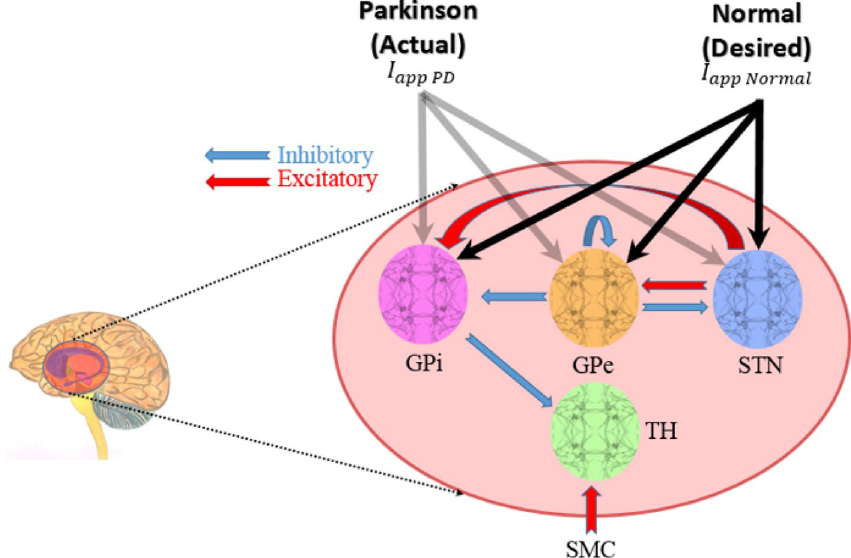
Figure 1. The BG-thalamic network layout for normal and PD conditions. Healthiness or Parkinsonian state is modeled by applying a specific set of I app currents to GPi, GPe, and STN populations (grey and black arrows for Parkinson and healthy states, respectively). The interconnections between different neuronal populations are also depicted which shows different excitatory or inhibitory connections between neurons. Excitatory and inhibitory connections are shown by red and blue arrows, respectively. The sensorimotor cortex excitatory current to the TH is denoted by SMC.